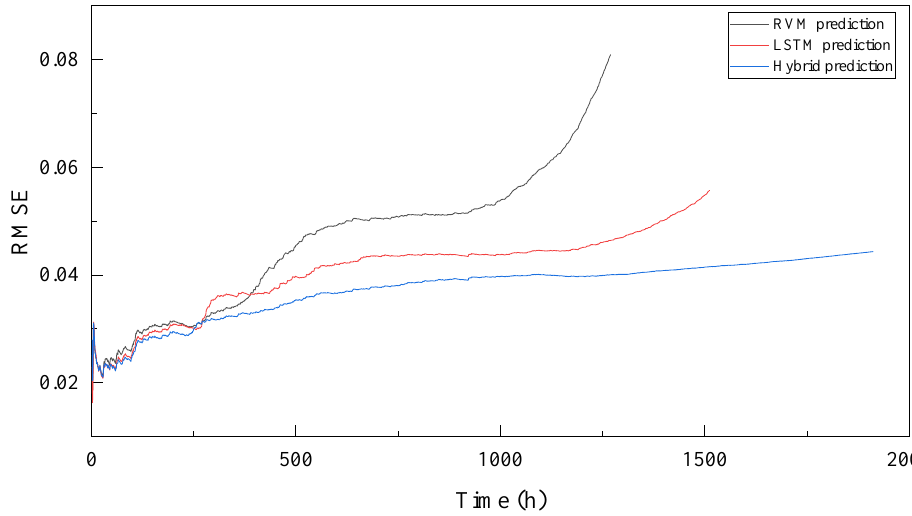
Figure 13. Comparison of prediction accuracy of different methods.